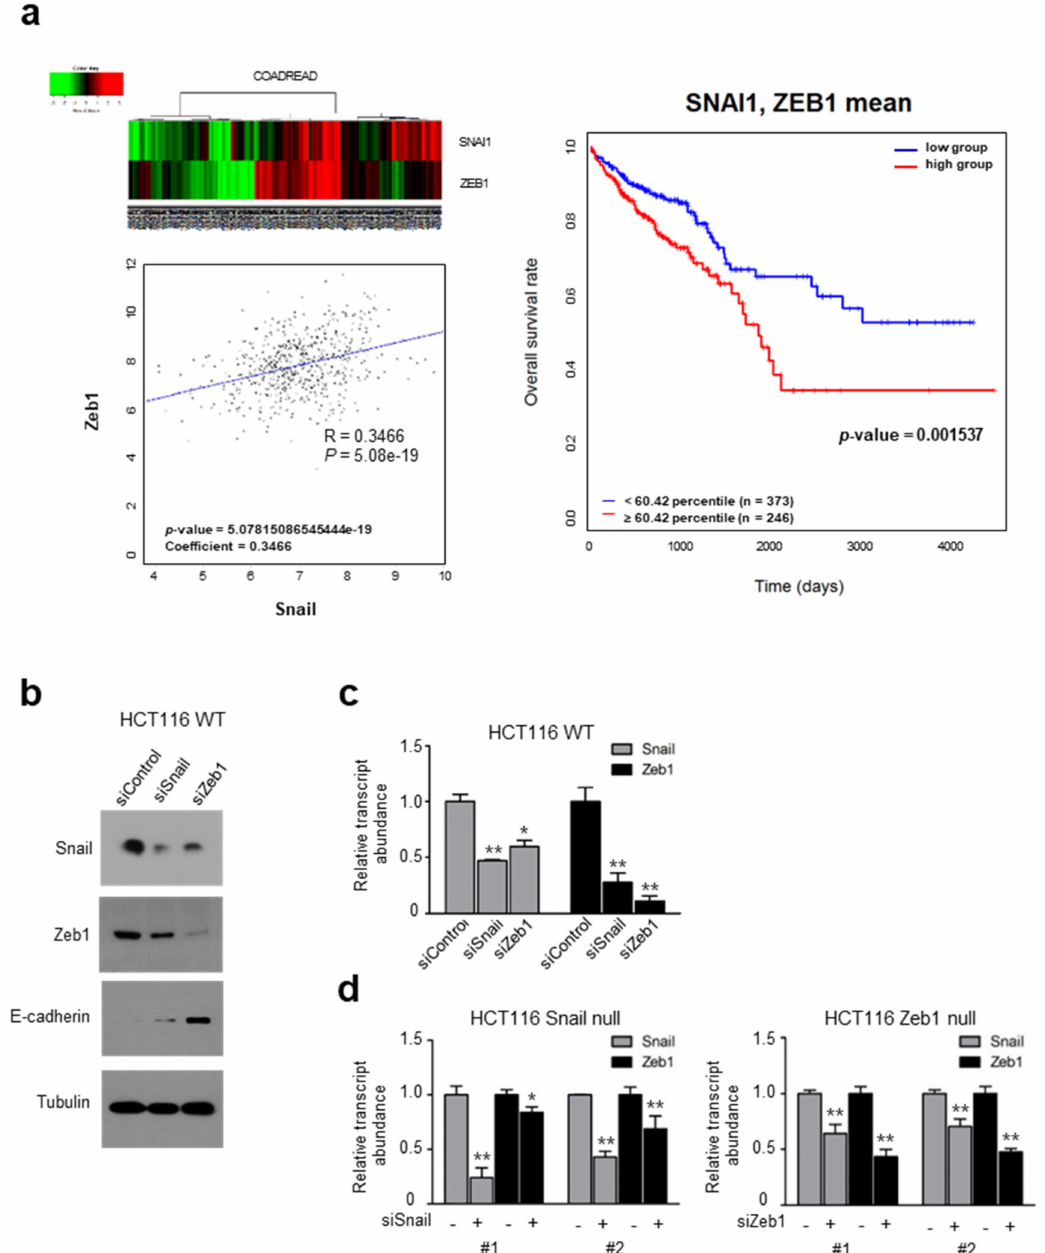
Figure 1. Concordant transcript abundance of Snail and Zeb1: ( a ) A supervised hierarchical clustering based on Snail and Zeb1 expression profiles (left upper panel) and Pearson correlation scatter plots of Snail and Zeb1 transcript in colorectal cancers (left lower panel). Kaplan–Meier survival graph for colorectal cancer patients with lower (blue line) or higher (red line) expression levels of Snail and Zeb1 on the basis of their transcript abundance at an optimal threshold, indicated by percentile number (right panel). In the heatmap, red denotes higher relative expression, whereas green indicates lower relative expression, with degree of color saturation reflecting the magnitude of the log expression signal; ( b ) Immunoblot analysis of Snail, Zeb1 and E-cadherin in HCT116 after siRNA-mediated knockdown of Snail and Zeb1. Tubulin was used as loading control. Representative blots are shown from at least two independent experiments; ( c ) Quantitative PCR (qPCR) analysis of Snail and Zeb1 after siRNA-mediated knockdown of Snail and Zeb1 in HCT116 (* p < 0.05, ** p < 0.01 compared with siControl, t -test); ( d ) In HCT116 of which Snail and Zeb1 were knocked out, respectively, by CRISPR-Cas9 systems, qPCR analysis of Snail and Zeb1 was performed after siRNA-mediated knockdown of Snail and Zeb1 (* p < 0.05, ** p < 0.01 compared with siControl, t